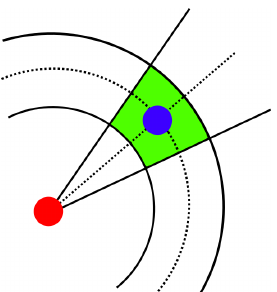
Figure 7. The red point is matched with the current position. The blue dot represents the relative position with the highest probability. Dotted lines marks the mean of the distribution for the step length and the direction. The green area is within the one sigma for both